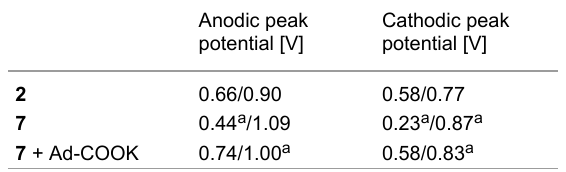
Table 1: Summary of peak potentials acquired by cyclic voltammetry (ferrocenyl oxidation or reduction/phenol oxidation or